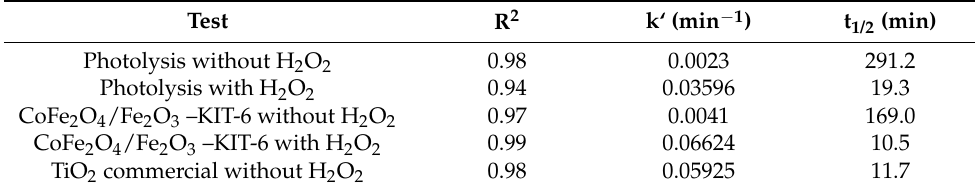
Table 4. Kinetic parameters for the dye degradation